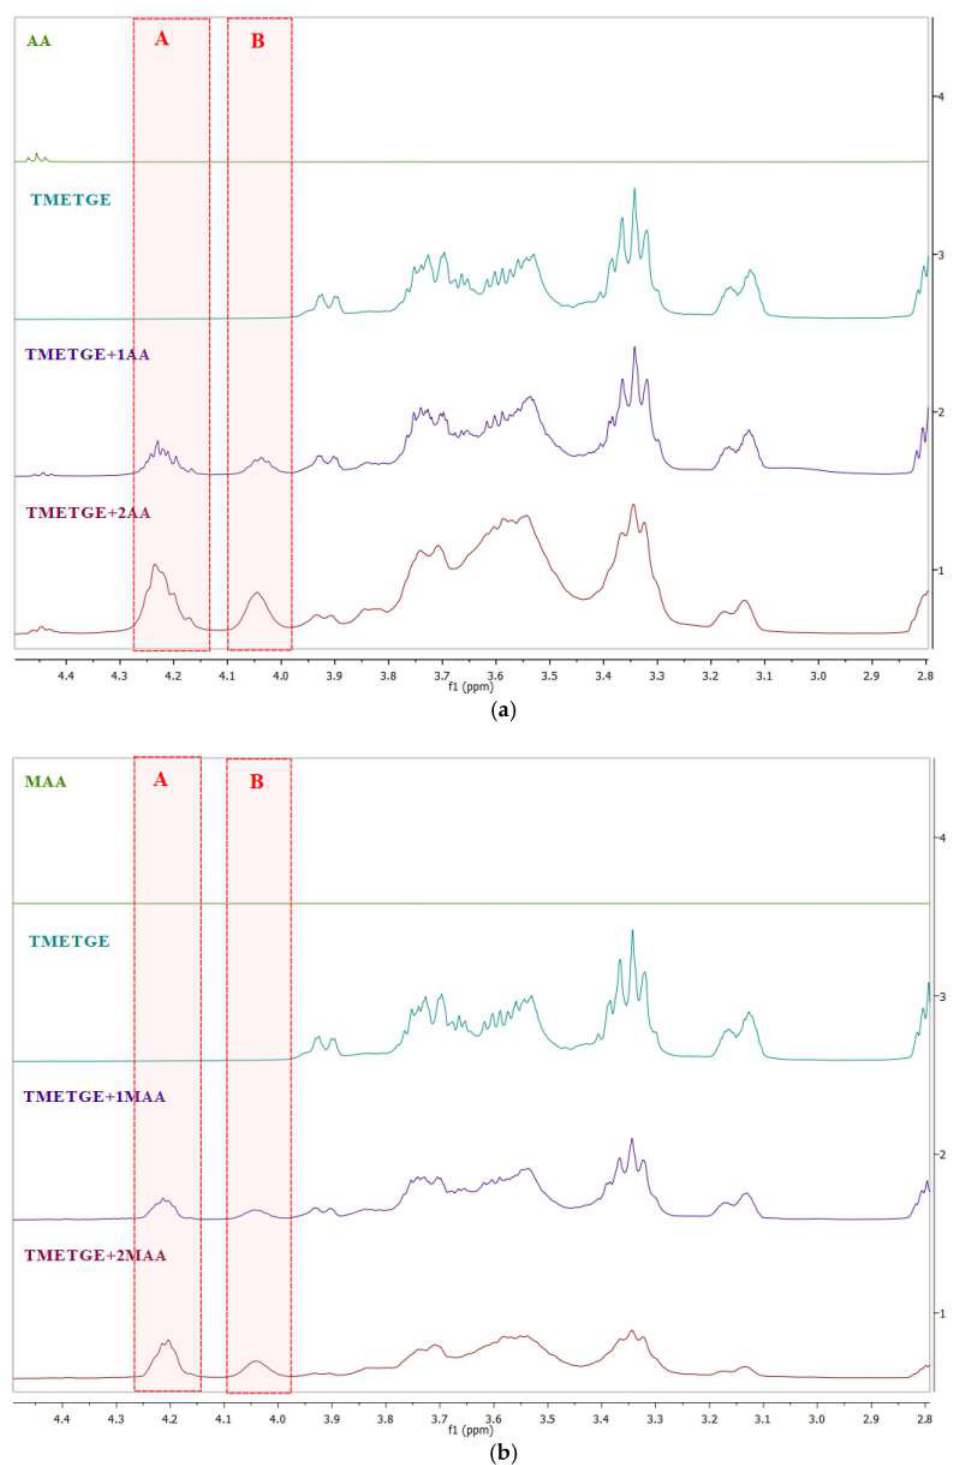
Figure 6. Fragments of the 1 H NMR spectra (CDCl 3 ) of ( a ) AA, triglycidyl ether of trimethylolethane, TMETGE + 1AA, and TMETGE + 2AA (from the top), ( b ) MAA, triglycidyl ether of trimethylolethane, TMETGE + 1MAA, and TMETGE + 2MAA (from the top) showing the formation of new